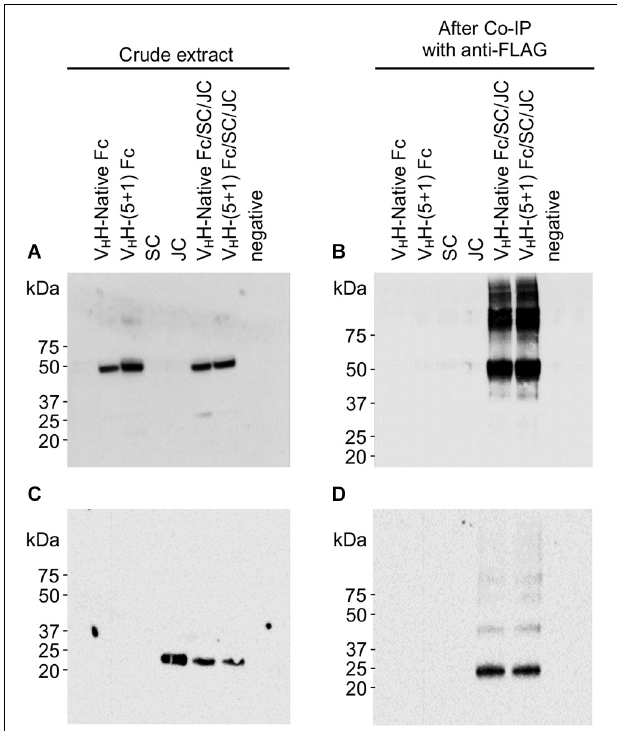
FIGURE 3 | V H H-(5 + 1) Fc retains the ability to assemble with other secretory IgA subunits SC and JC. Shown are Western blots probed with either anti-cmyc (A,B) or anti-HA (C,D), which correspond to differently tagged subunits V H H-Fc and JC respectively. Leaf issue was transformed with constructs of each subunit individually and also with combinations of V H H-Fc/SC/JC and V H H-(5 + 1)Fc/SC/JC for intended co-expression and assembly. Detection was done for both diluted crude leaf extract (A,C) and for the eluent after the extract had been co-immunoprecipitated using an anti-FLAG column (B,D) .